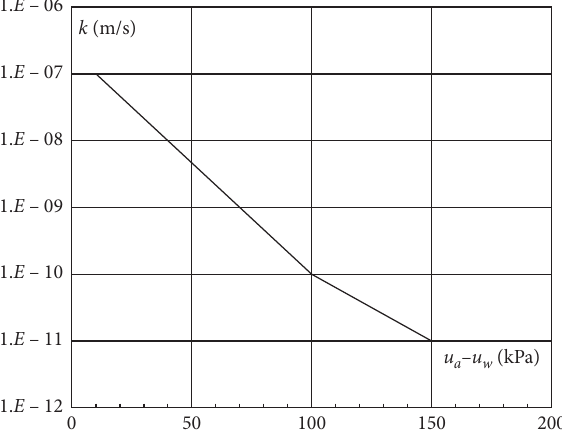
Figure 4: Permeability function for analyzing transient seepage [15].